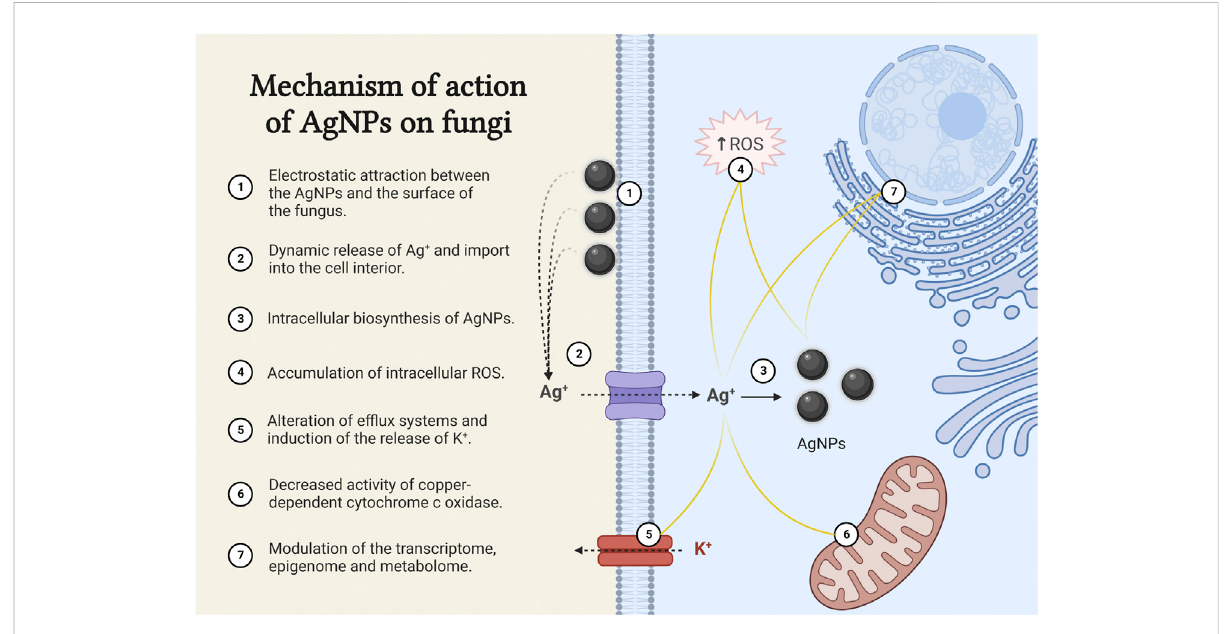
FIGURE 1 Mechanism of action of AgNPs on fungi. The fi gure was created with